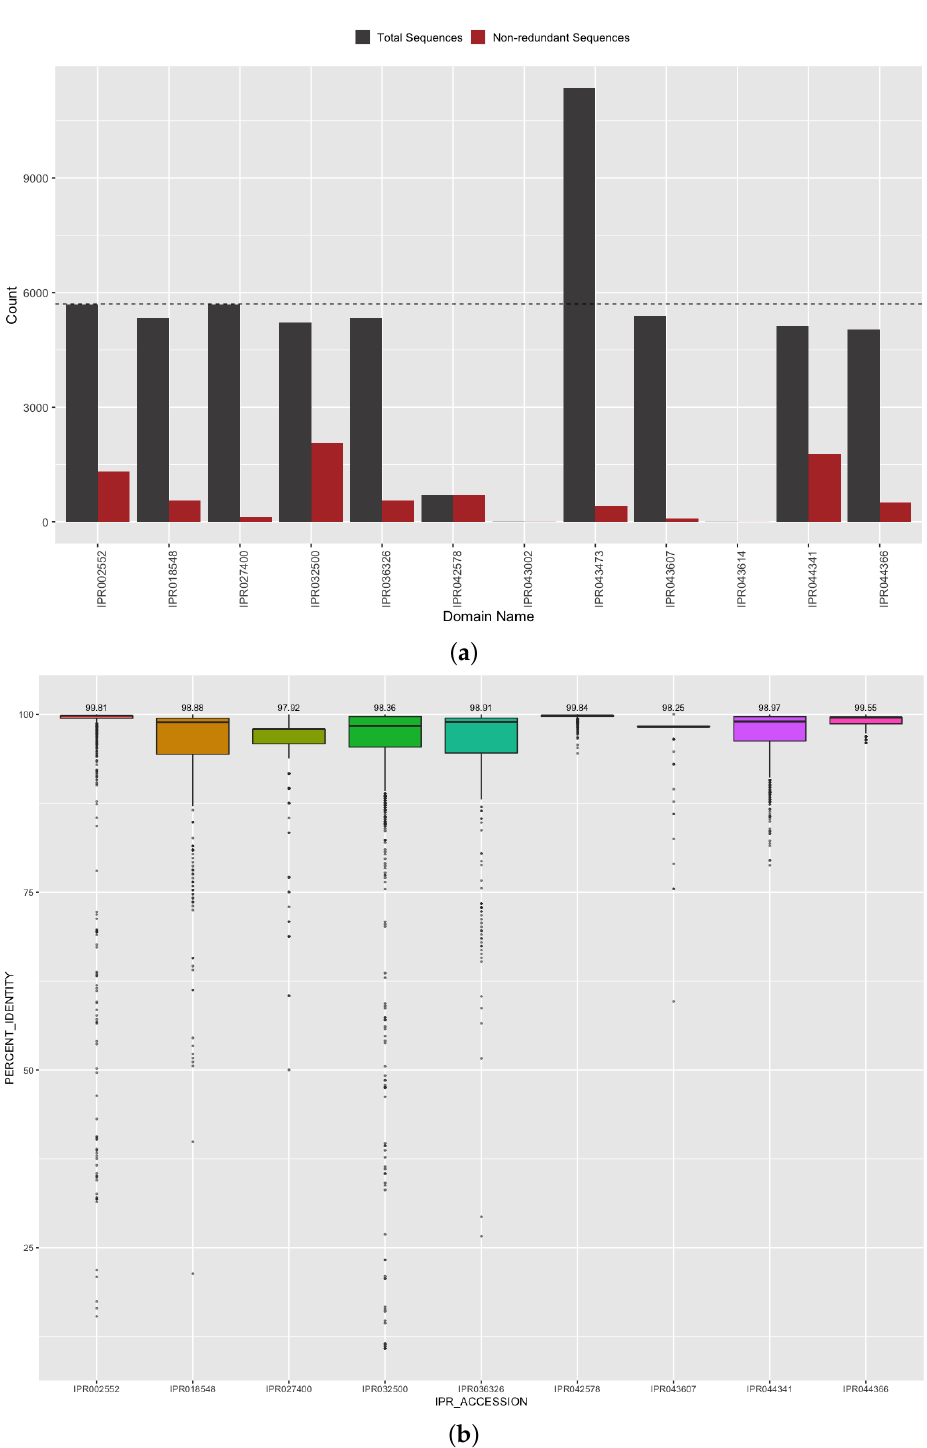
Figure 7. Domain annotation set membership and sequence accuracy for spike glycoprotein. ( a ) Set membership of all (grey) and distinct (red) domain sequences identified in spike glycoprotein. Count indicates the number of times a given domain was observed for all S proteins (dashed line). ( b ) The percent identity of our predicted domain sequences is calculated against reference domain sequences. For false positive domains not present in the spike protein, there is no reference sequence; therefore, these entries are omitted from this